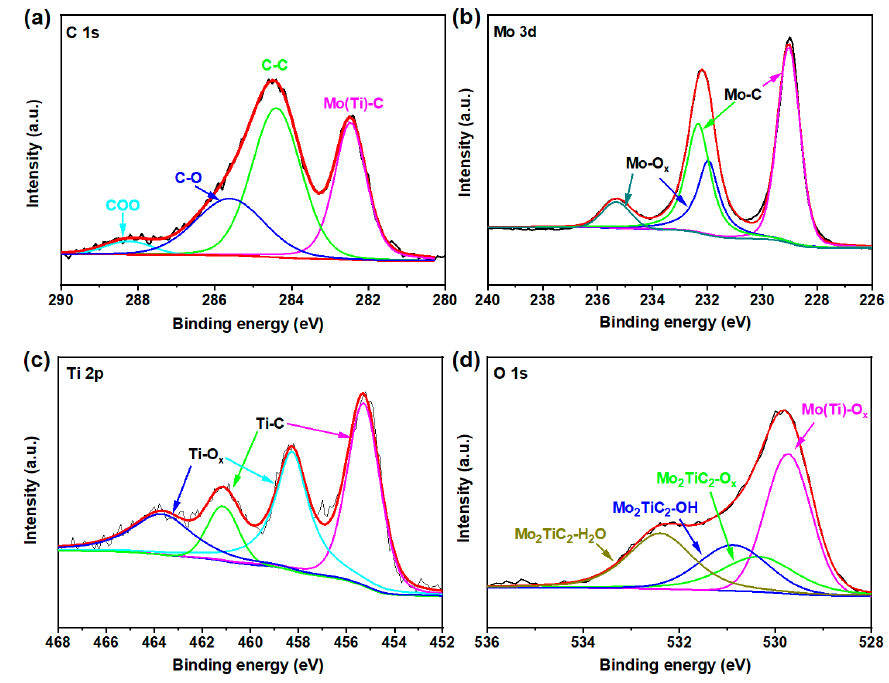
Figure 4. High-resolution XPS spectra of O-Mo 2 TiC 2 : ( a ) C 1s, ( b ) Mo 3d, ( c ) Ti 2p, and ( d ) O 1s.